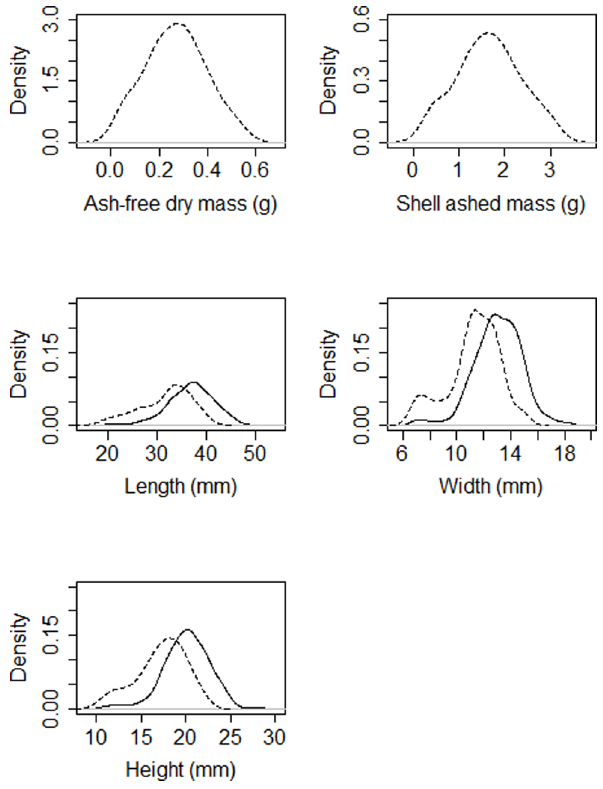
Figure 1. Density distributions of body characteristics derived using kernel density estimation. Dashed lines indicate distributions derived using only the 50 individuals sampled for dry mass. Solid lines are distributions derived using all 275 individuals sampled. Note that shell dimensions (width, length and height) in the sub-sample of mussels sampled for dry mass tend to overrepresent the smallest individuals. Normal distributions were good approximations for all of these data (Table 2).